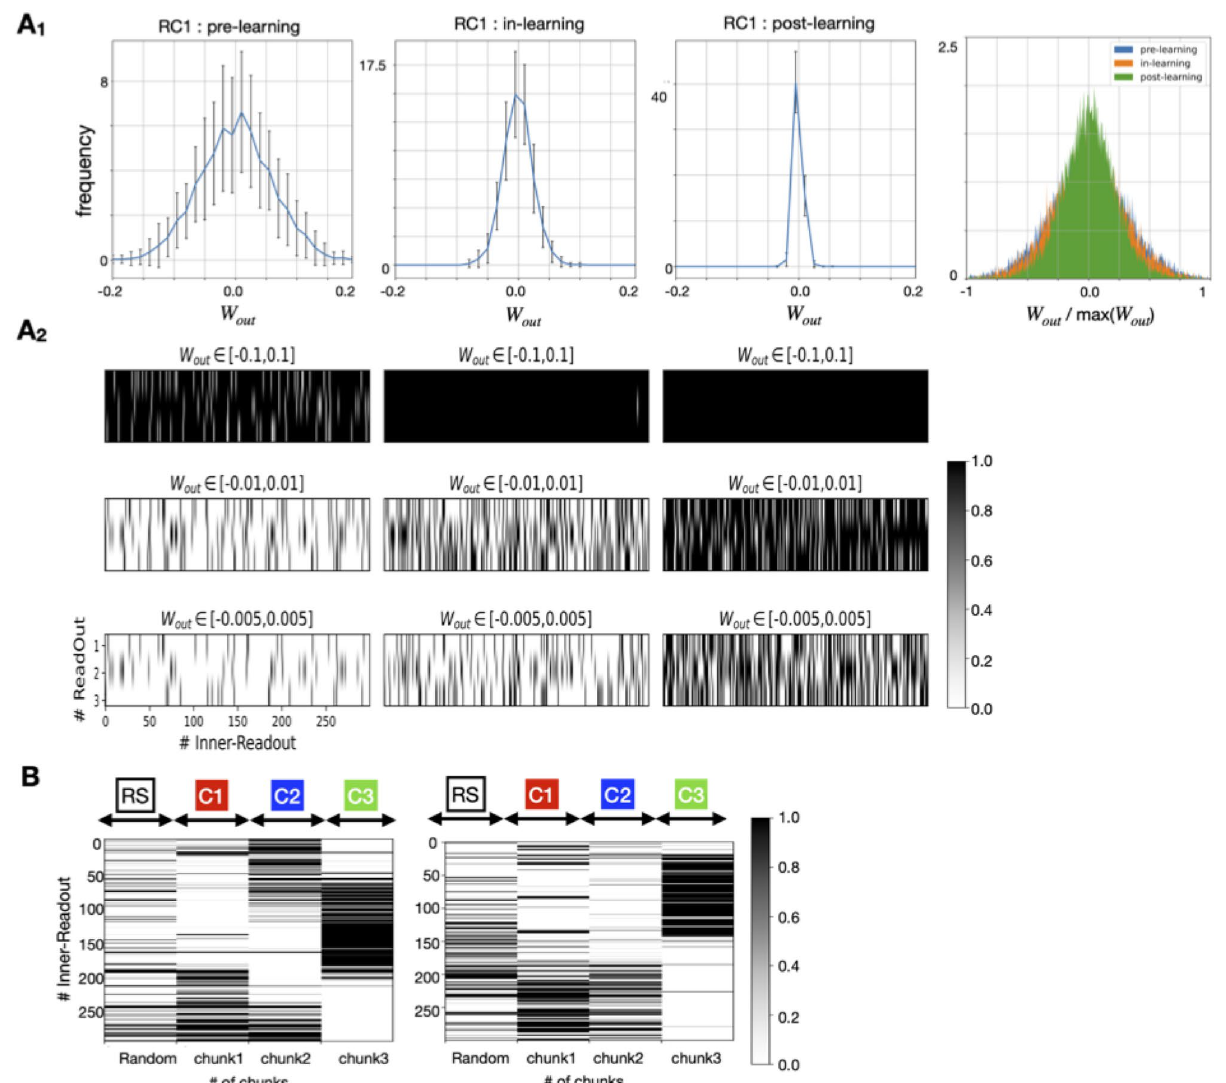
Figure 3. Evolution of reservoir-readout connections during and after learning. ( A 1 ) Time changes of distribution in the weight matrix connecting the reservoir internal unit to the readout unit. On the far right, a distribution of normalized connection magnitudes is shown for comparison with the distribution shapes across the stages of learning. The connections were normalized by the maximum value for each timing ( A 2 ). A detailed distribution of reservoir-readout connections is shown before, during, and after learning within the indicated range of W out . White indicates that only a small portion of connections fall within a given range, whereas black indicates that many connections fall within a given range. ( B ) Selective decode responses to individual chunks (colored intervals) are self-organized. The input contains random sequences. The responses are gray-scaled according to their selectivity to the chunks. Left: the case where selectivity to a specific chunk by reservoir neuron projecting to readout units was clear. Right: the case where the selectivity was less